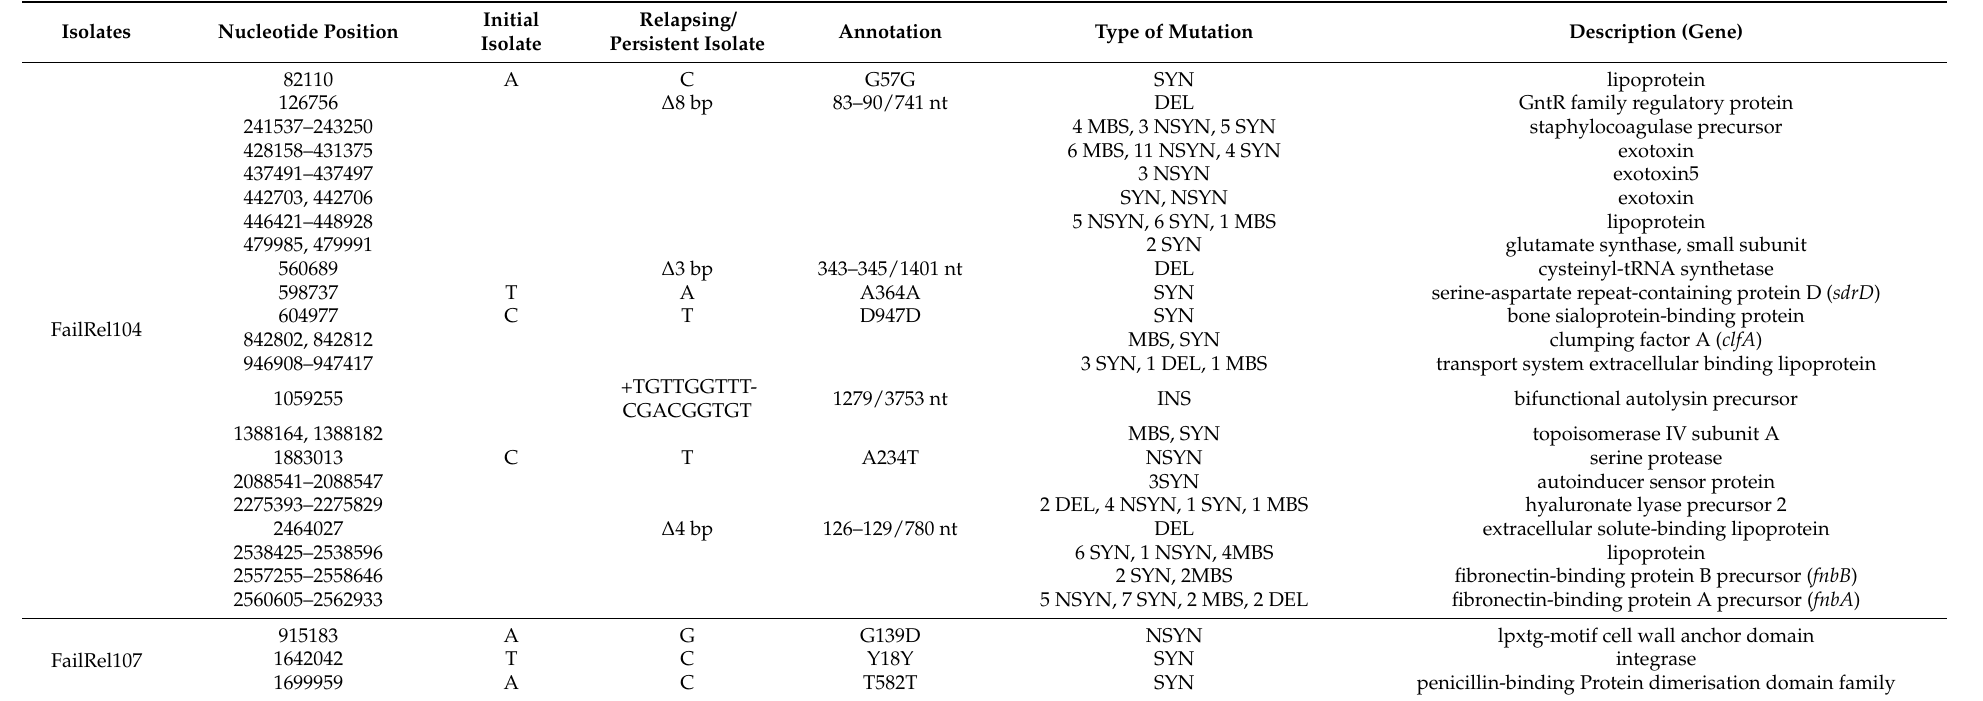
Table 3. Variants between relapsing or persistent isolates from the same